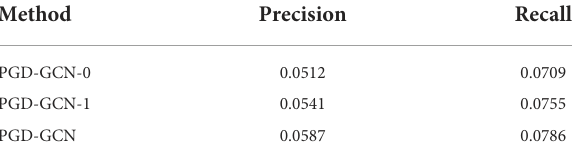
TABLE 6 Results of variants on Foursquare.